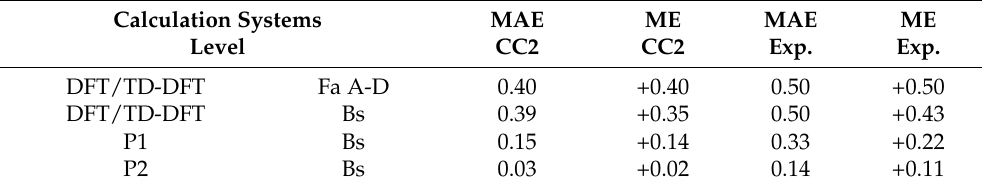
Table 4. MAE and ME (eV) on the adiabatic ZPVE-corrected excitation energies of the lowest ππ * 318 excited state (S 1 ) between DFT/TD-DFT, P1 or P2 and CC2 or Experiment. For DFT/TD-DFT only